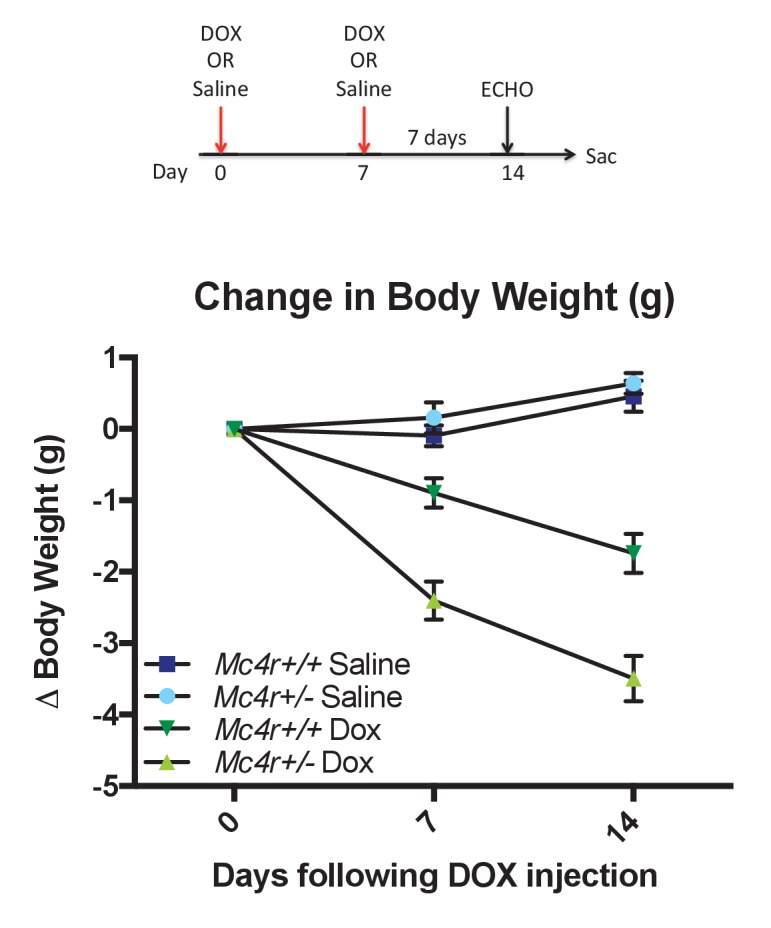
Mc4r ± mice are hypersensitive to doxorubicin.(A) Treatment strategy to subclinical cardiac dysfunction in WT C57B6/J mice. Mice were given 5 mg/kg doxorubicin over the course of 2 weeks during which time their bodyweights were recorded. (B) Body weights of Mc4r+/- and WT during the course of the treatment paradigm. Mc4r+/- mice almost twice as much weight as their WT controls. (One Way ANOVA, p<0.05, n = 6–14).10.7554/eLife.28118.025Figure 12—source data 1.Source data for Figure 12B.This source file provides mean, SD, sample size and statistical test information for the doxorubicin studies outlined in Figure 12A and presented in Figure 12B.